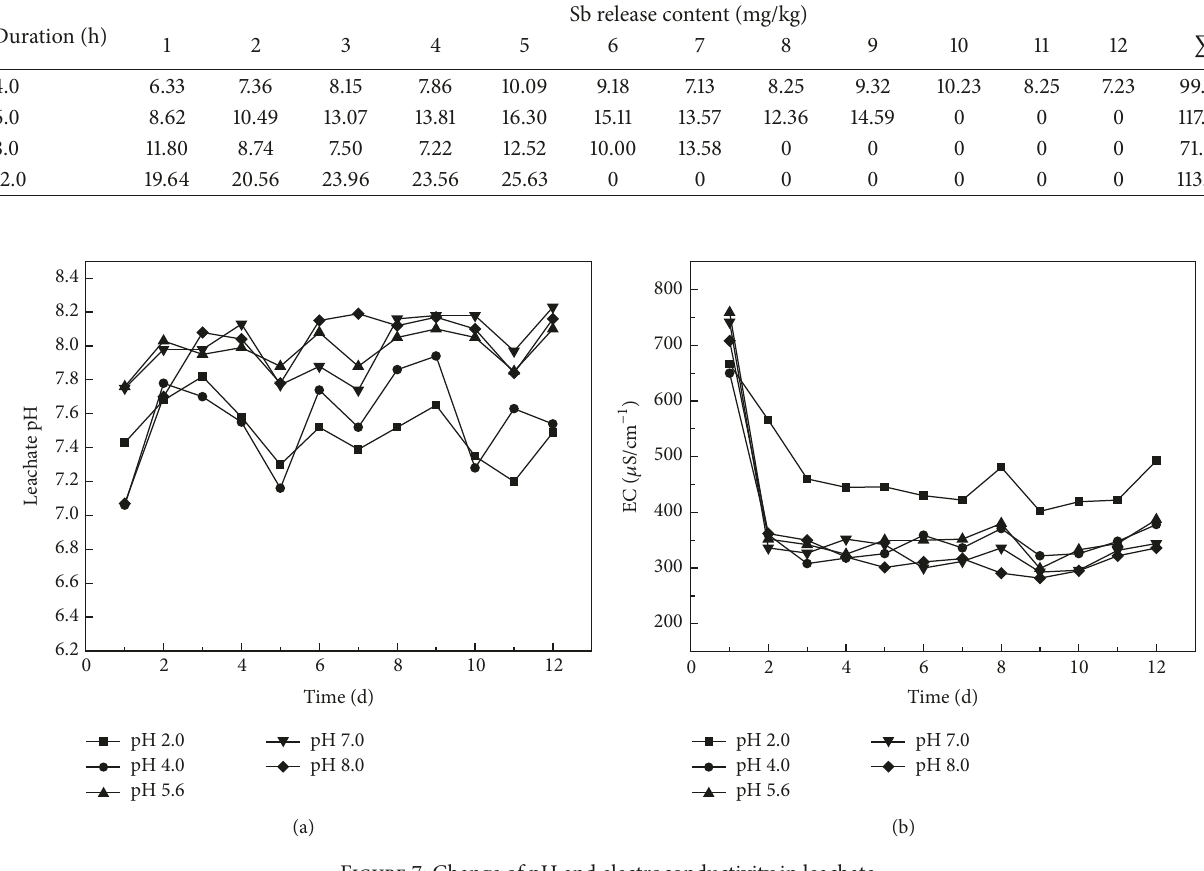
Figure 7: Change of pH and electroconductivity in leachate.